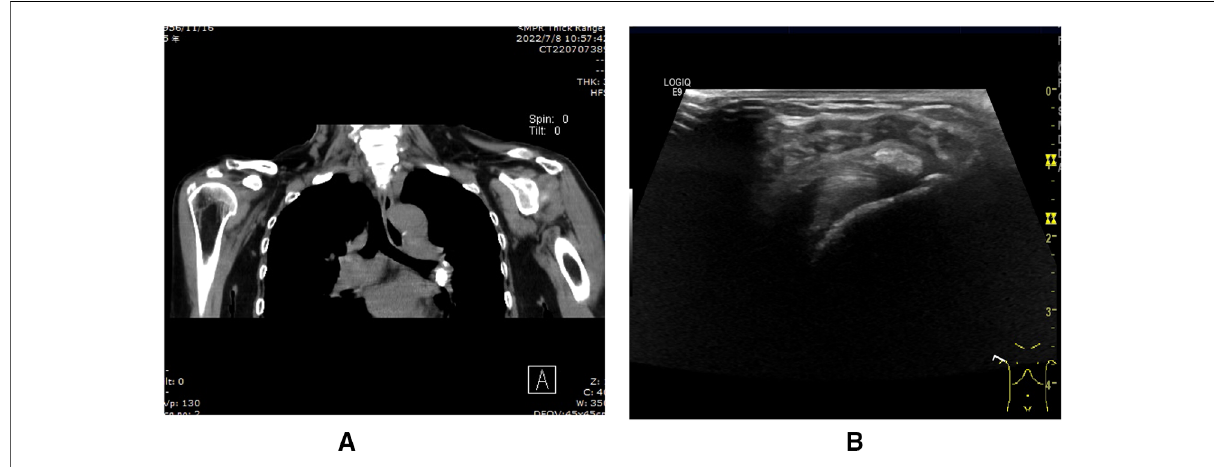
FIGURE 3 ( A ) Calci fi cation foci of supraspinatus tendonitis on preoperative CT. ( B ) Calci fi c tendonitis calci fi cation foci on preoperative shoulder.